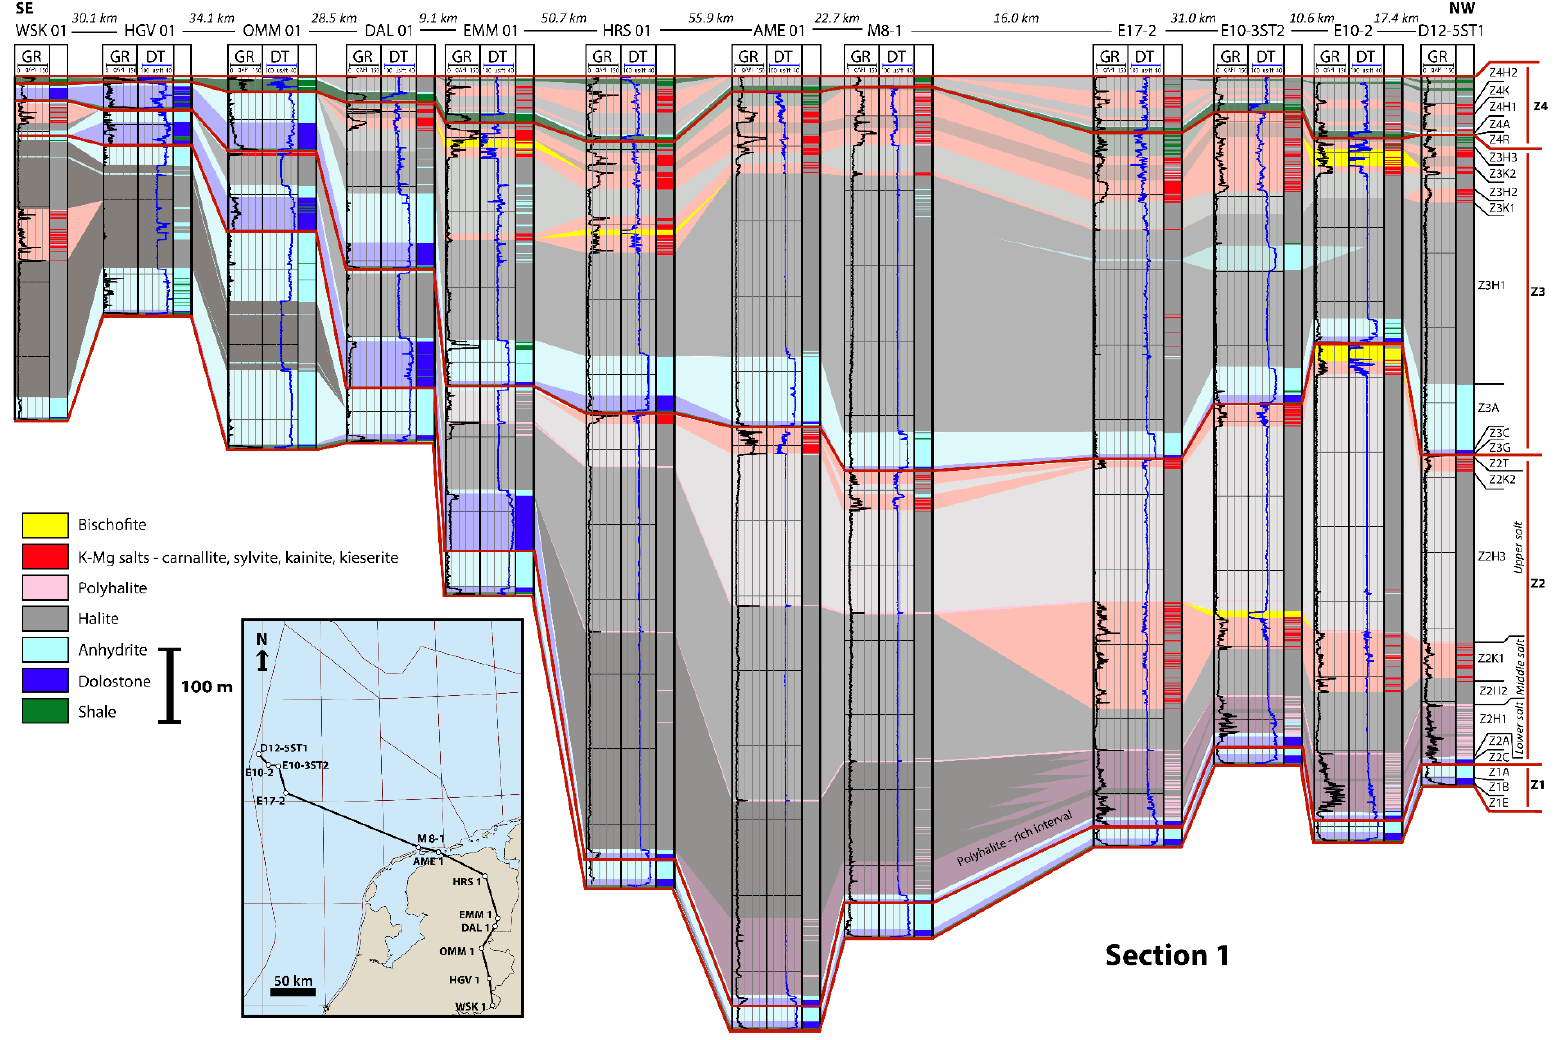
Figure 3. Correlative cross ‐ section 1.